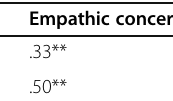
Table 3 Correlations with dispositional empathy (IRI) Cognitive empathy Affective empathy IRI-perspective taking